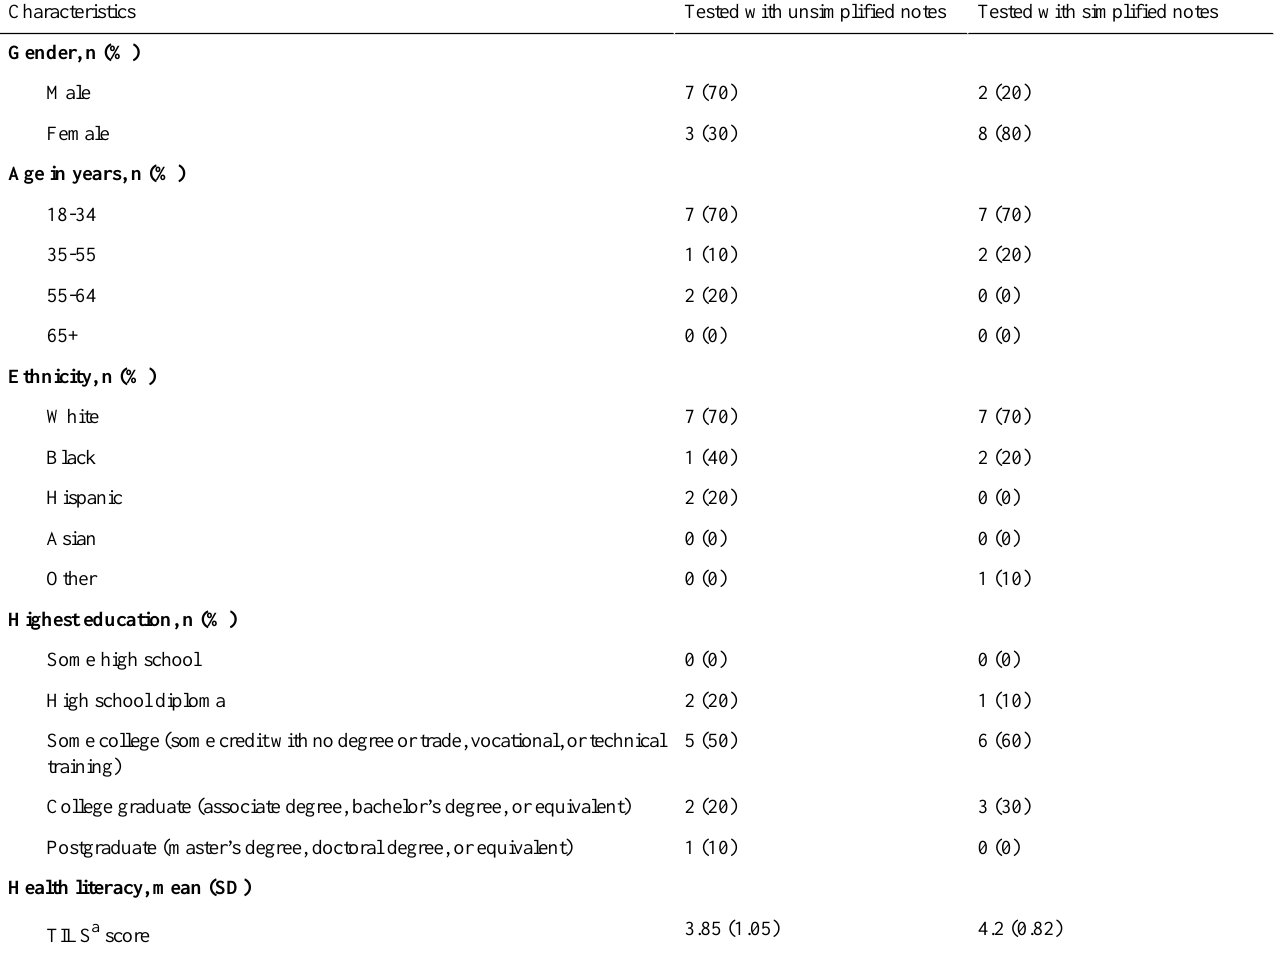
Table 1. Study demographics